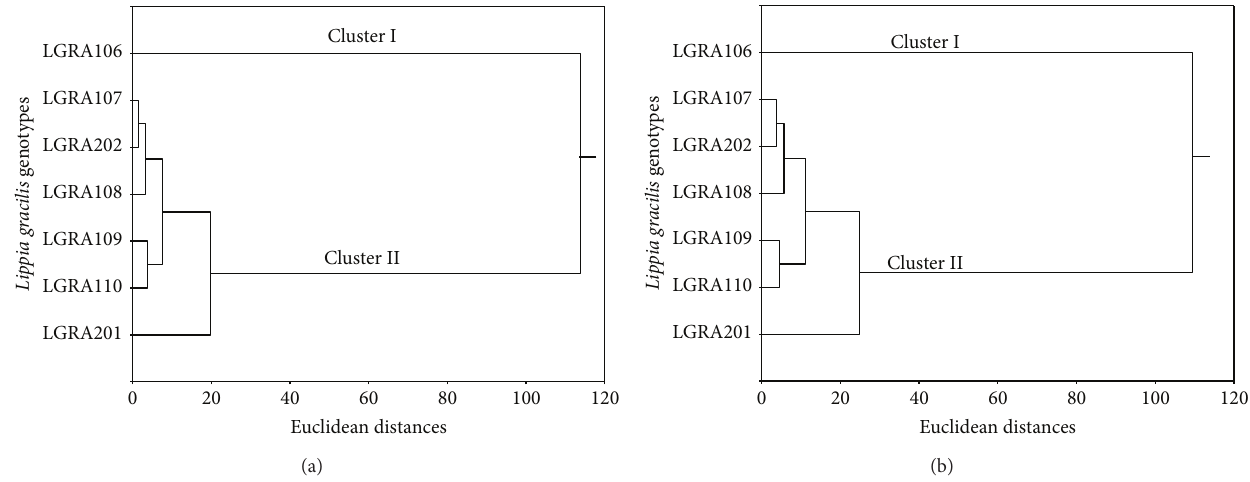
Figure 4: Bidimensional dendrograms representing the similarity of the chemical composition between seven L. gracilis genotypes for plants cultivated with (a) and without (b) irrigation.